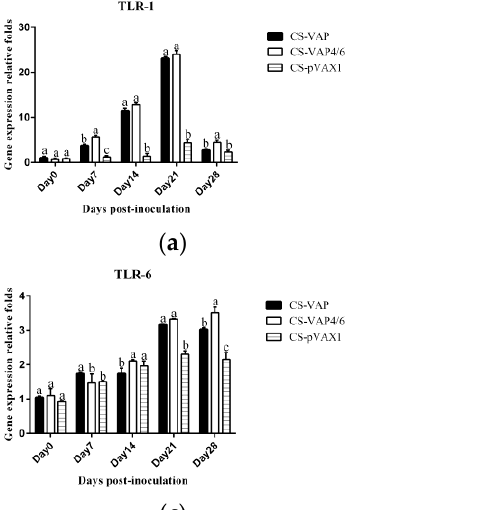
( c ) Figure 10. Expression levels of IL-7 ( a ), IL-15 ( b ), and IL-23 ( c ) immune memory genes of experimental mice. The expression levels of IL-7, IL-15, and IL-23 genes in treated groups had significant increases compared with the control group in the whole period ( p < 0.05). The group treated with CS-VAP4/6 got a higher expression level of IL-15 gene at 14 to 28 days in comparison with CS-VAP ( p < 0.05). Meanwhile, a higher expression of IL-23 gene was found in CS-VAP4/6 at 14 days compared with CS- VAP ( p < 0.05). 3.6.4. Change of Expression Levels of Cytokine Genes In order to evaluate the immune response of experimental mice, the gene expression levels of IL-1, IL-2, IL-4, IL-6, IL-12, IFN-γ, and TNF-α were detected. The results are shown in Figure 11. Figure 11a,d,f show that there were significant increases in expression levels of IL-1, IL-6, and TNF- α of CS-VAP and CS-VAP4/6 compared with CS-VAP from 7 to 28 days ( p < 0.05), respectively; moreover, CS-VAP4/6 had higher expression levels of IL-1, IL-6, and TNF-α during such a period ( p < 0.05). Expression levels of IL-4, IL-12, and IFN-γ genes were markedly up-regulated in groups CS- VAP and CS-VAP4/6 from 7 to 28 days compared with CS-pVAX1 ( p < 0.05); meanwhile, the group treated with CS-VAP4/6 got higher expression levels of IL-4, IL-12, and IFN-γ genes at 14 and 21 days in comparison with CS-VAP ( p < 0.05) (Figure 11c,e,g). Figure 11b shows that the expression levels of IL-2 gene in groups CS-VAP and CS-VAP4/6 were significantly increased compared with CS-pVAX1